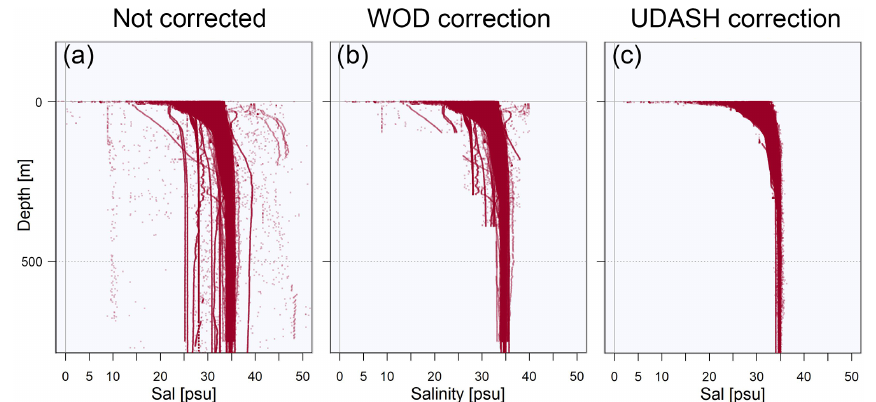
Figure 9. WOD salinity data in the Amerasian Basin. (a) Data without correction. (b) Accepted data according to the WOD quality flags. (c) Accepted data according to the UDASH quality flags.